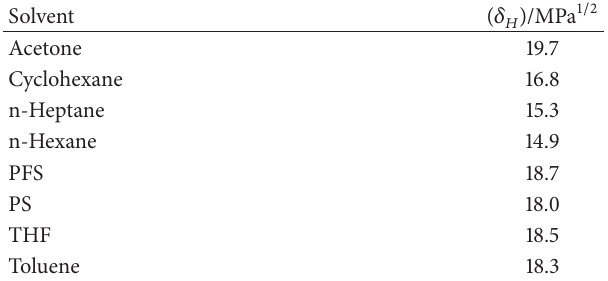
Table 1: Hildebrand solubility parameter ( 𝛿 𝐻 ) of solvents.